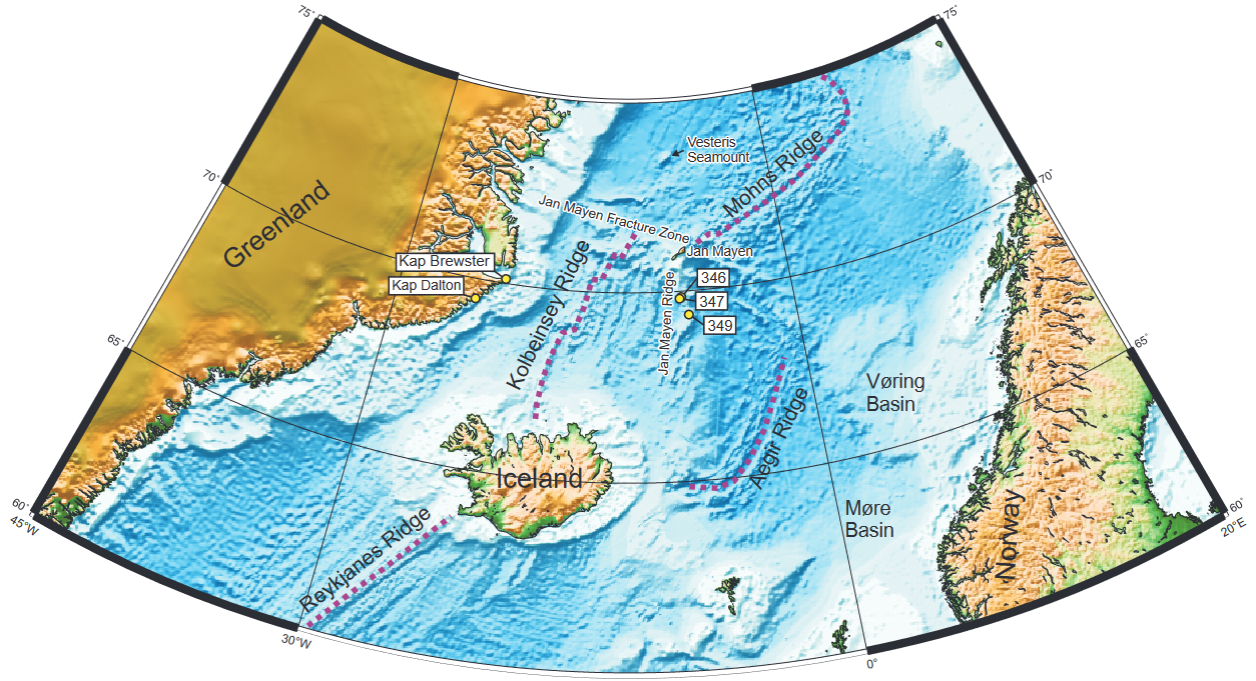
Figure 1. Map of the Norway-Greenland Sea showing the location of Jan Mayen, the three Deep Sea Drilling Project sites discussed in this paper, Kap Brewster and Kap Dalton in East Greenland, and the Vesteris Seamount.